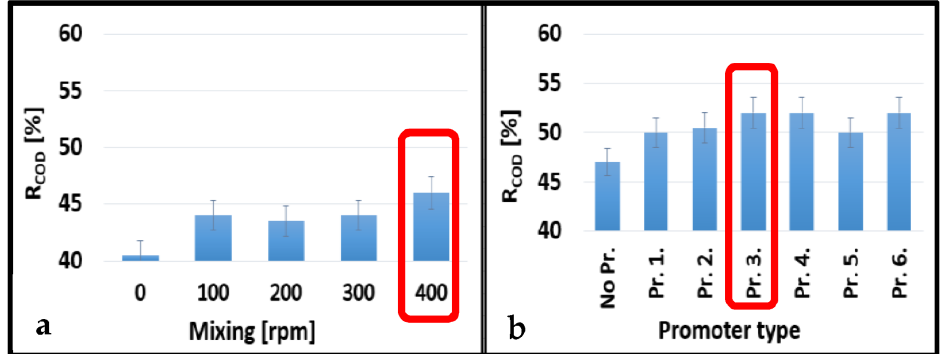
Figure 7. Effects of mixing speeds without 3DP turbulence promoters ( a) and promoter types at 400 rpm mixing ( b ) on the average COD rejections for a 150 kDa NMWL UF membrane. 400 rpm mixing ( b ) on the average COD rejections for a 150 kDa NMWL UF